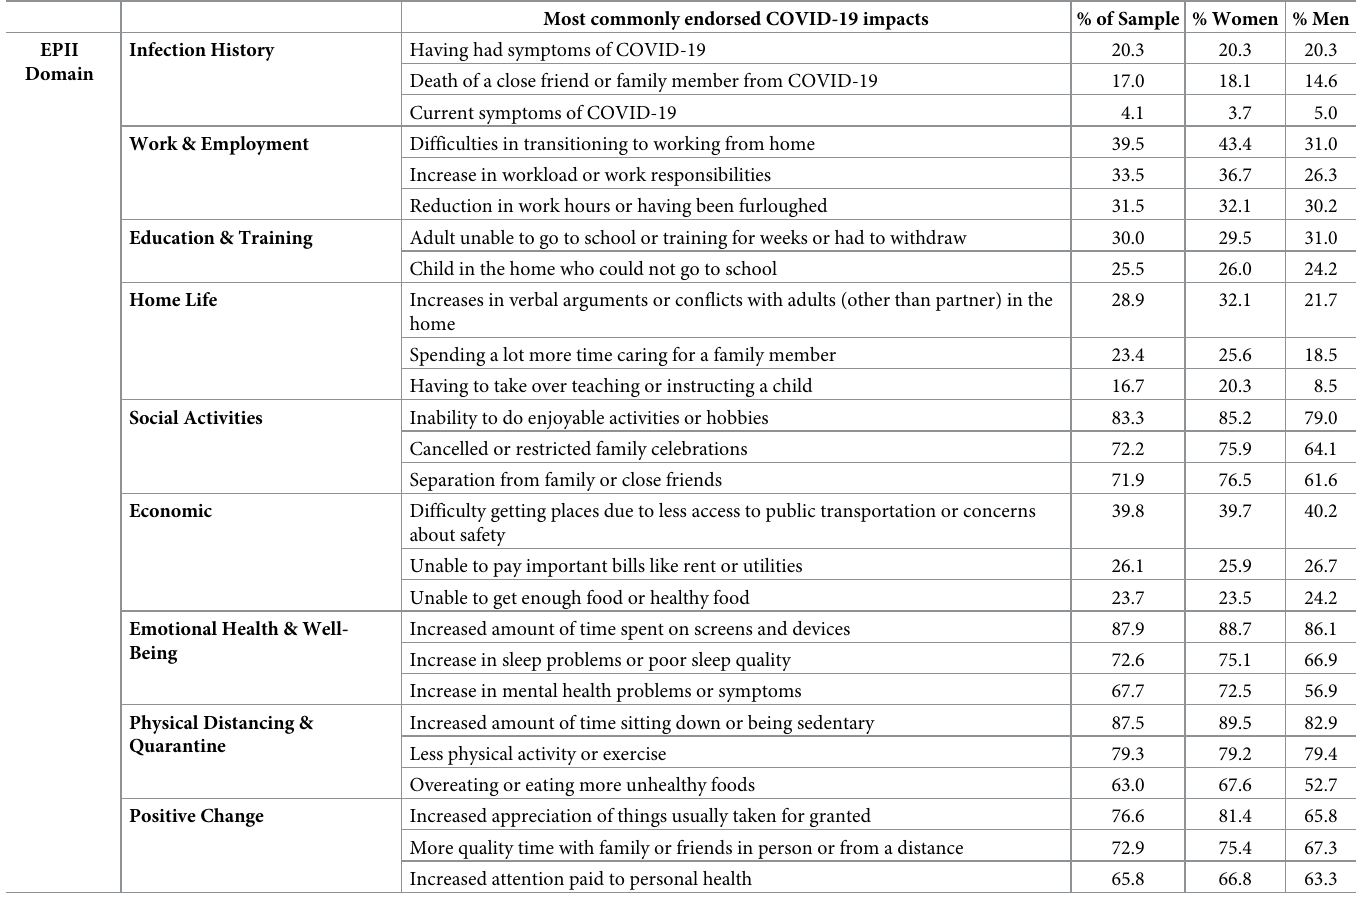
Table 3. Most common COVID-19 impacts in each EPII domain by the surveyed student sample (N = 909) and by